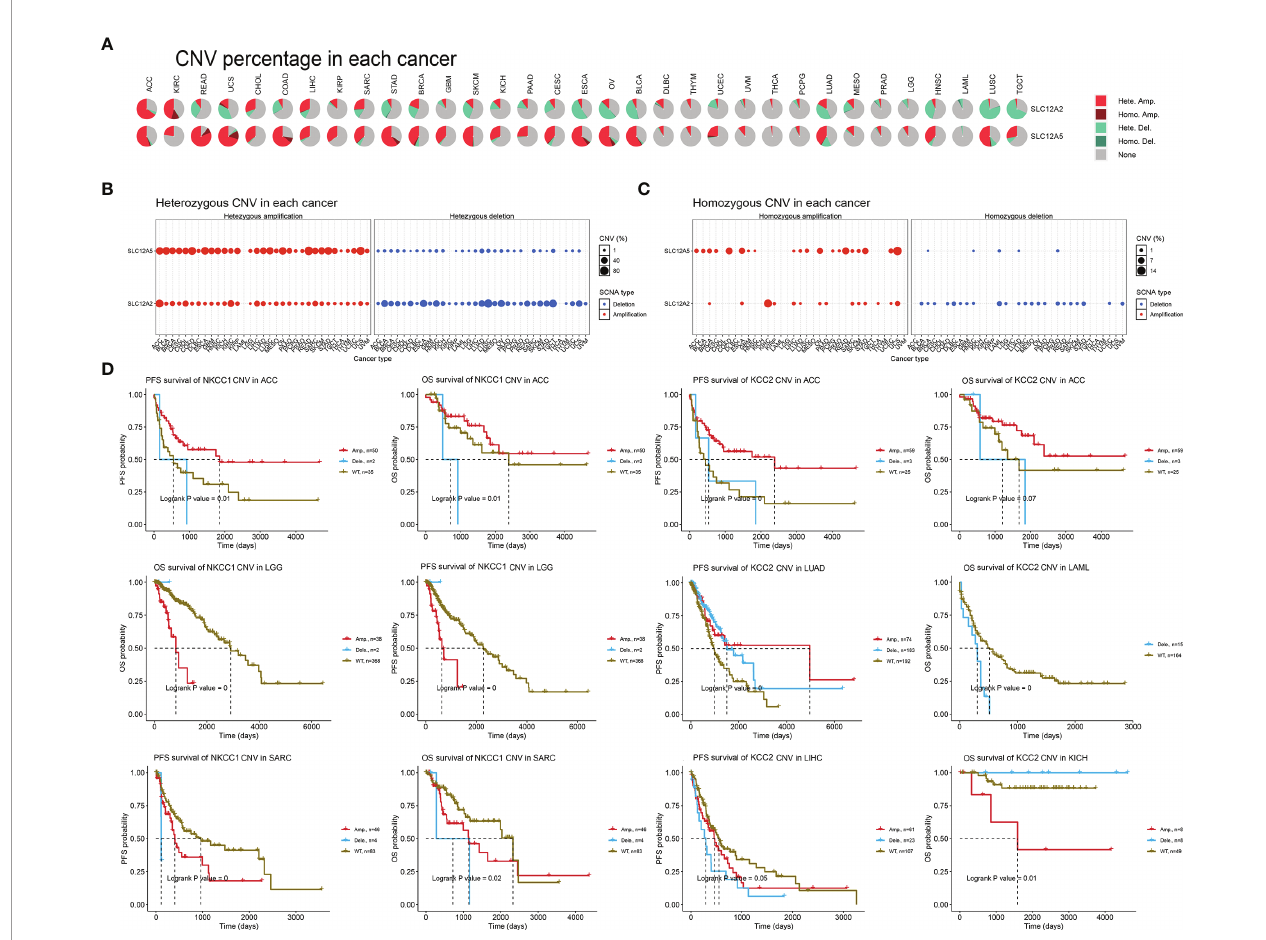
FIGURE 7 | The landscape and prognostic signi fi cance of CNV of KCC2 and NKCC1 in pan-cancer from TCGA. (A) Association between KCC2 and NKCC1 heterozygotes and heme ampli fi cation and deletion. (B) CNV characteristics of KCC2 in pan-cancer patients (heterozygous or heme ampli fi cation or deletion). (C) CNV characteristics of NKCC1 in pan-cancer patients (heterozygous or heme ampli fi cation or deletion). (D) KCC2 and NKCC1 with high frequency of CNV in pan-cancer and the impact on the prognosis of cancer